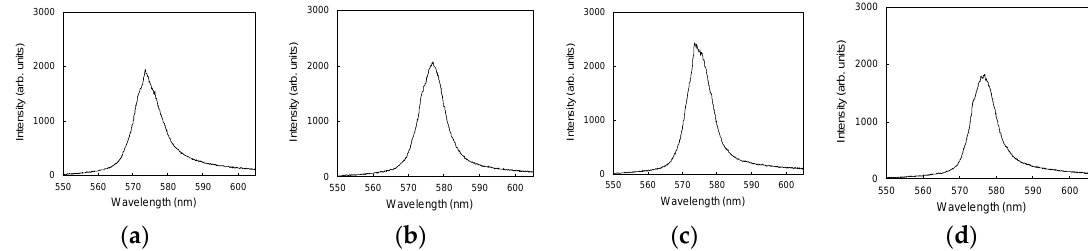
Figure 3. Emission spectra obtained with the circular excitation pattern for SP volume fractions of ( a ) 0%, ( b ) 5%, ( c ) 10%, and ( d ) 15%. The volume fraction of scattering particles is 10%. The pumping energy and energy density are 4 µJ and 1.3 mJ/mm 2 , respectively.